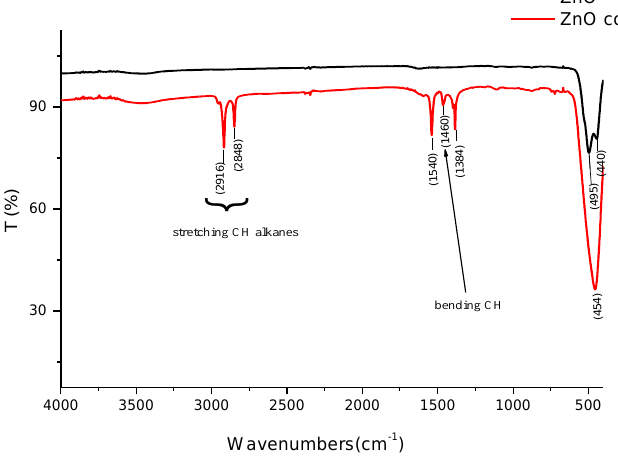
Figure 3. FT-IR spectrum of ZnO and ZnOc powder.